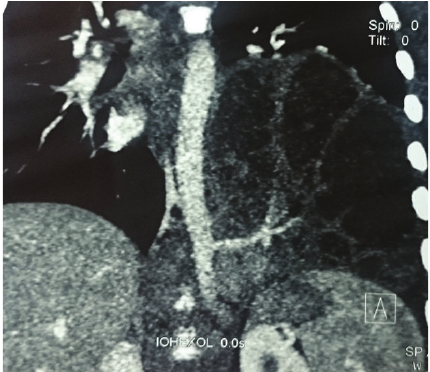
Figure 3: CT angiography shows intralobar lung sequestration with anomalous blood supply from the descending thoracic aorta.